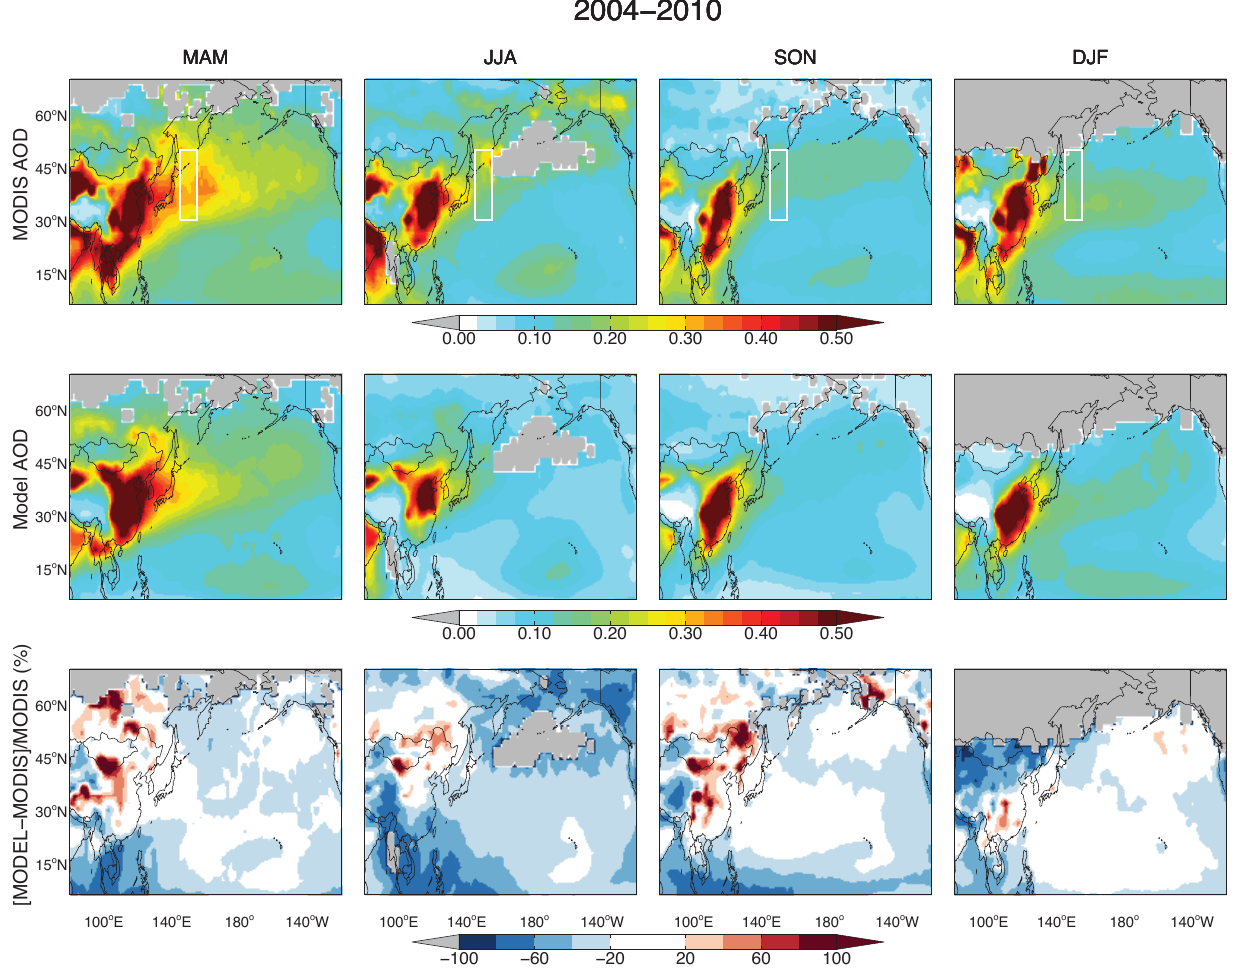
Fig. 1. Comparison between MODIS (top row) and GEOS-Chem (middle row) AOD over the North Pacific in different seasons over 2004– 2010. From left to right: Spring (MAM), Summer (JJA), Fall (SON), and Winter (DJF). Panels in the bottom row show the percent difference between GEOS-Chem and MODIS AOD. The grey color represents missing data or cloudy conditions in the MODIS observations. The model is sampled only on the days when MODIS data is available. The white box in the top rows defines the Asian outflow region used